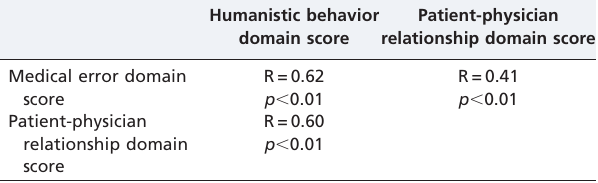
Table 5 - Correlations among the medical error, patient- physician relationship and humanistic behavior domains. Humanistic behavior Patient-physician domain score relationship domain score Medical error domain